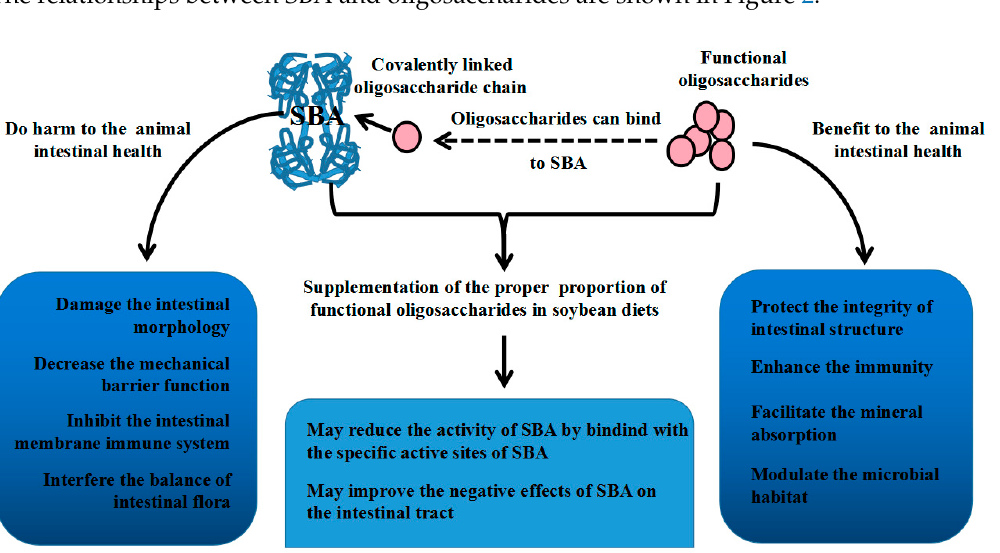
Figure 2. The relationship between SBA and oligosaccharides.